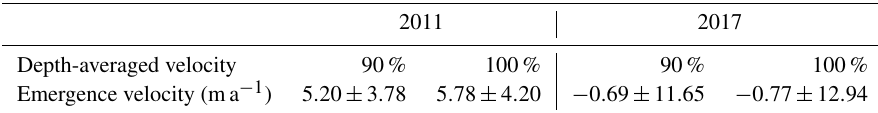
Table 2. Comparison of the emergence velocity of Thorthormi Glacier in 2011 and 2017. The mean values are calculated for the 2400– 3500m section from the 2002 terminus (Fig. S4). Two basal sliding conditions are assumed, whereby depth-averaged velocity equals either 90% or 100% of the surface